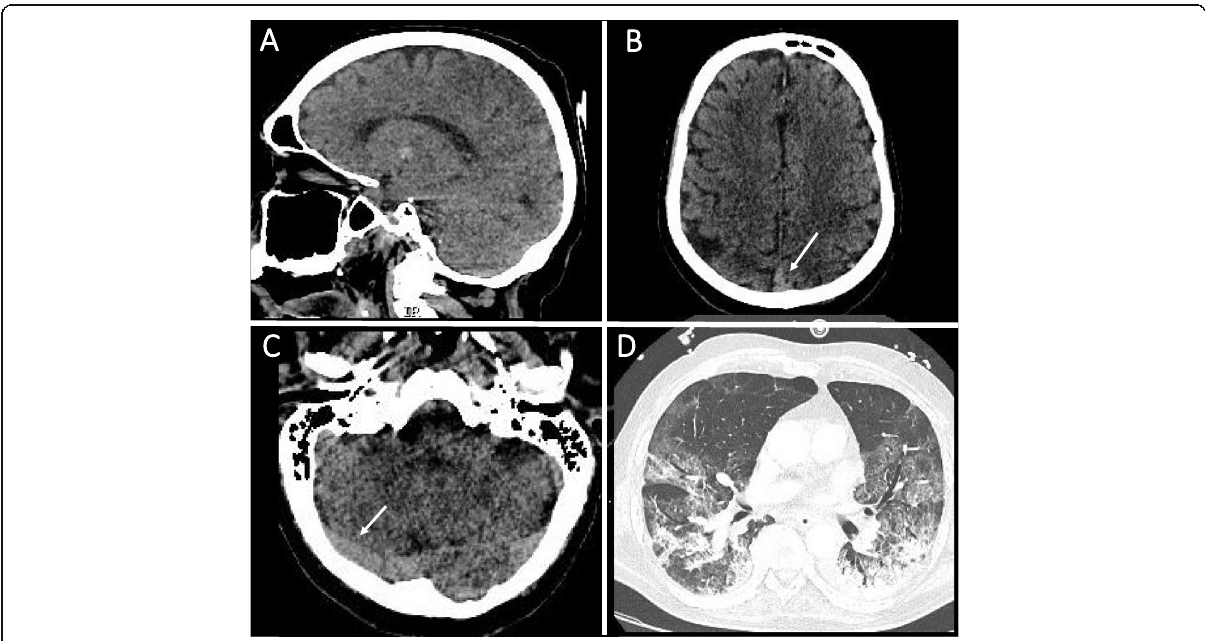
Fig. 2 Subacute onset of cerebral sinus venous thrombosis in a man with COVID-19 and ARDS. A Sagittal head NCCT scan showed hyperdense at superior sagittal sinus and right transverse sinuses. B Axial head NCCT scan showed hyperdense at superior sagittal sinus (white arrow) and brain parenchymal edema on the left parietal lobe. C Axial head NCCT scan showed hyperdense at right transverse sinus (white arrow). D Axial thorax CT-scan showed ground-glass opacity and subpleural bilateral, with the fibrotic appearance in both